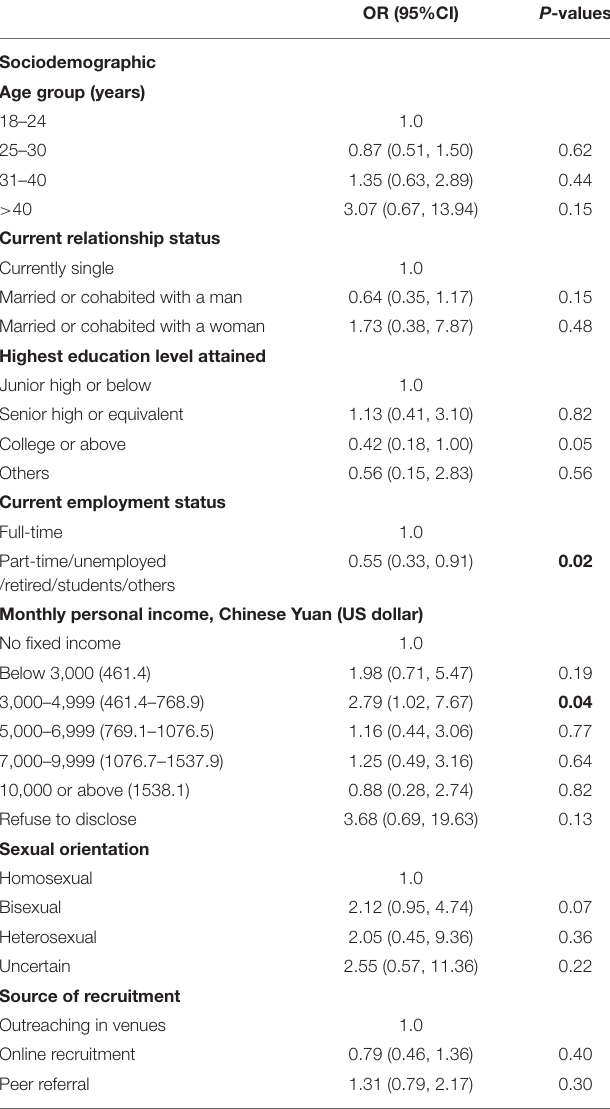
TABLE 4 | Associations between baseline sociodemographic and uptake of any type of HIV testing during the follow-up period ( n = 412). OR (95%CI) P